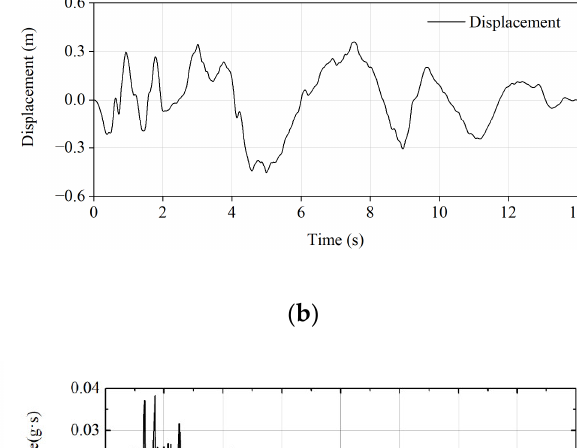
Figure 5. The arrangement of acceleration sensors and displacement sensors: ( a ) the GSI–RSM test; ( b ) the non-isolation test.